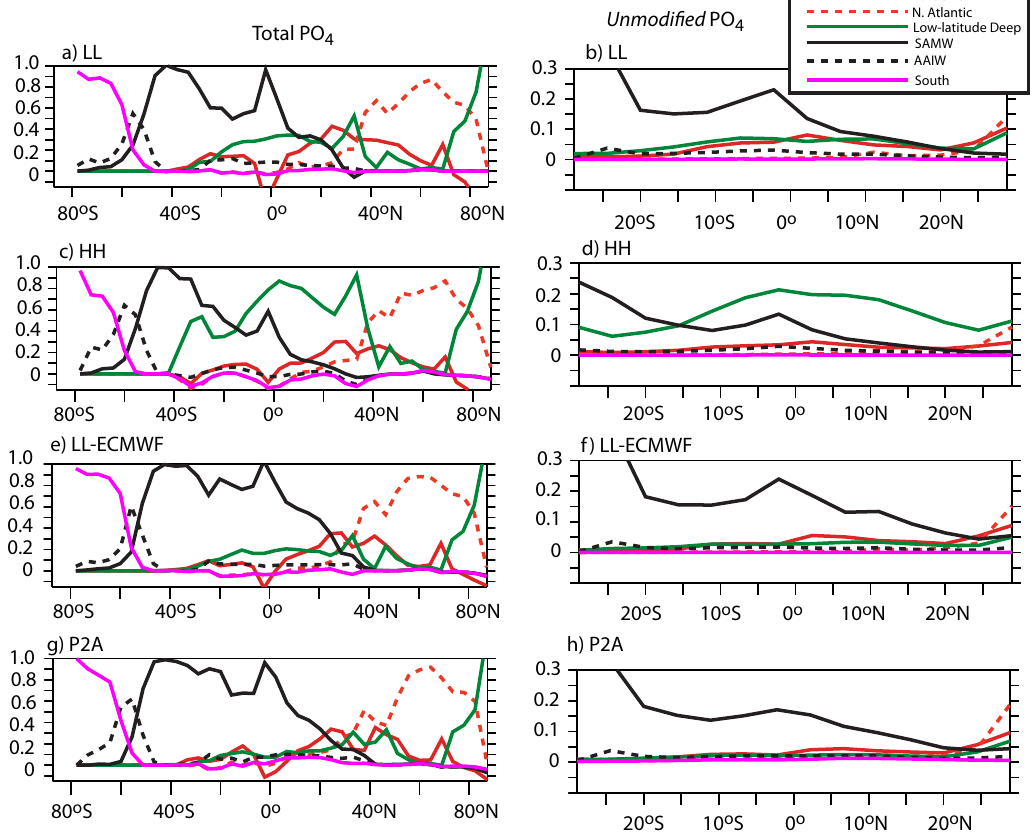
Fig. 11. The zonally-averaged fraction of export production fueled by phosphate ( unmodified+remineralized ) from each of the tagging regions (left column) and by the unmodified component of each tagged phosphate between 30 ◦ S and 30 ◦ N (right column) for the four models described in Table 1. Note the panels on the left show the full latitude range of the model ocean, while the panels on the right show only the low-latitudes. The contribution of the remineralized components of tagged phosphate to sustaining low latitude productivity is the difference between the contributions of the total tagged phosphate (left) and the unmodified component of the tagged phosphate (right). Negative values reflect the method used to diagnose the export production fueled by each tagged nutrient using the source/sink terms for DOP and PO 3 − , as described at the end of Sect. 2.3. The lines refer to phosphate from the North Pacific (red solid), North Atlantic (red 4 dotted), Deep low latitude (green solid), SAMW (black solid), AAIW (black dotted), and Southern (magenta solid) regions (refer to Fig. 4 for tagging protocol). Note the different horizontal and vertical scales for the left and right